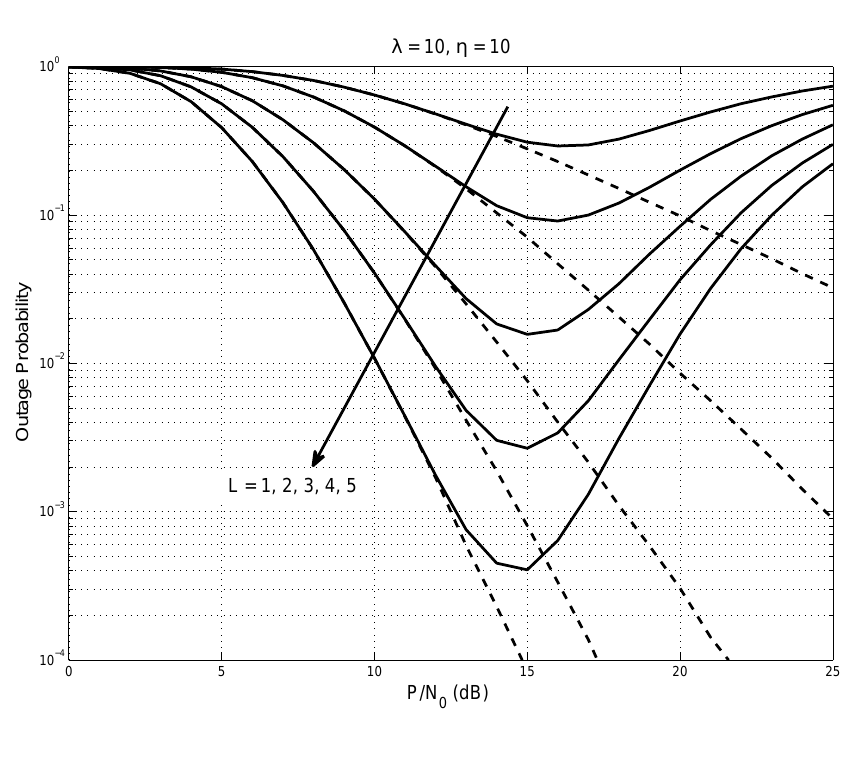
Figure 3. Outage probability of the system with L = 1, 2, 3, 4, 5 for interference constraint λ = 10 and outage threshold η =